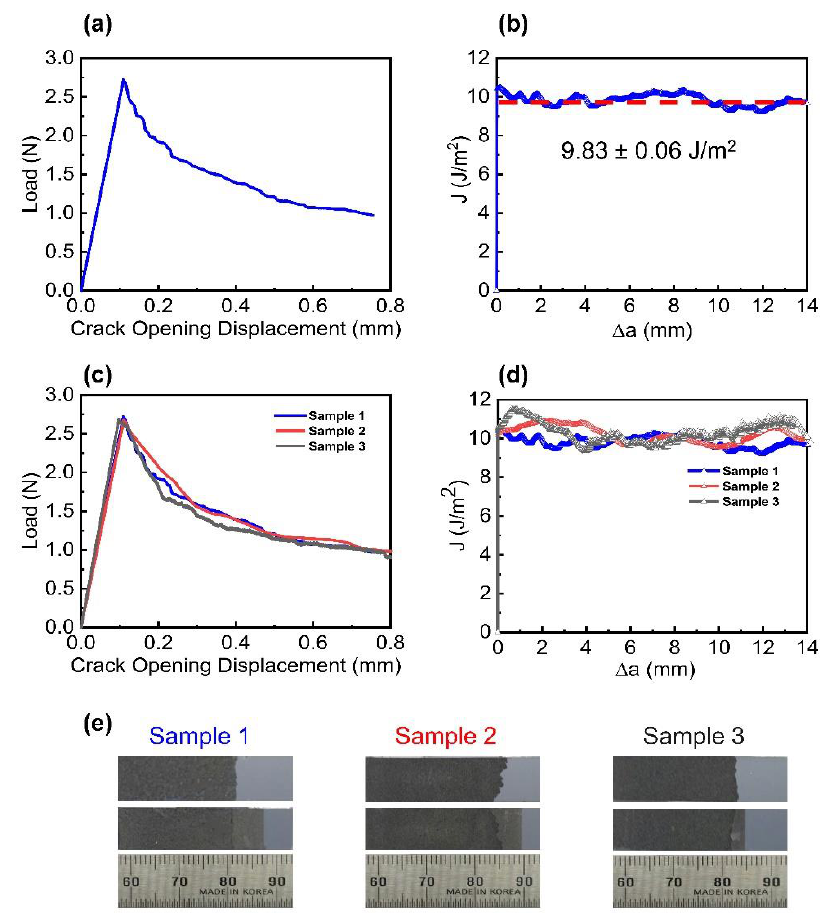
Figure 4. Interlayer separation behavior of the EEG paper: ( a ) force–displacement responses and ( b ) corresponding fracture resistance curve; ( c ) force–displacement curves and ( d ) corresponding fracture resistance curves of the three DCB specimens. Interfacial fracture behavior of the interface of the EEG paper. The red dashed line in ( b ) represents the average interlayer separation energy obtained from ( d ); ( e ) photograph of the fracture surfaces of the three DCB specimens.